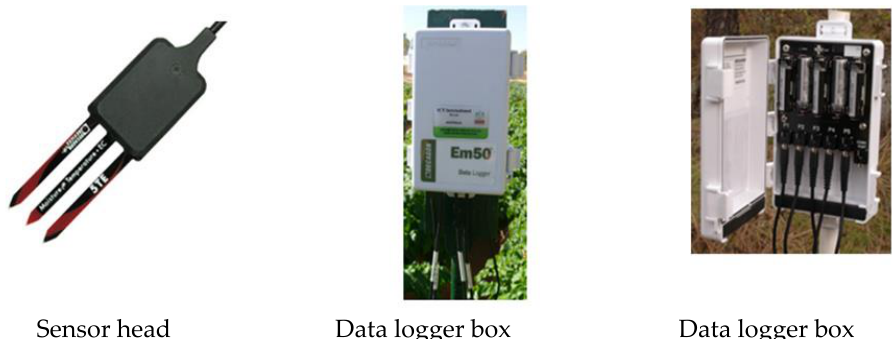
Figure 1. ECH2O-5TE sensors in all rubs of testing.